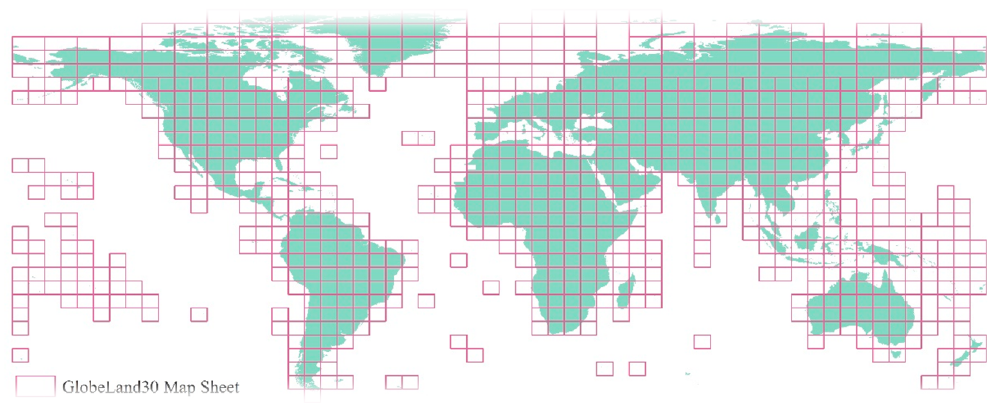
Figure 2. Data tiles of GlobeLand30.